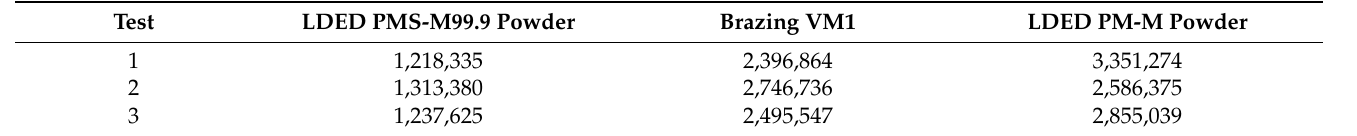
Table 7. Volumetric wear values of Mo layer after fretting wear tests (μm 3 ).